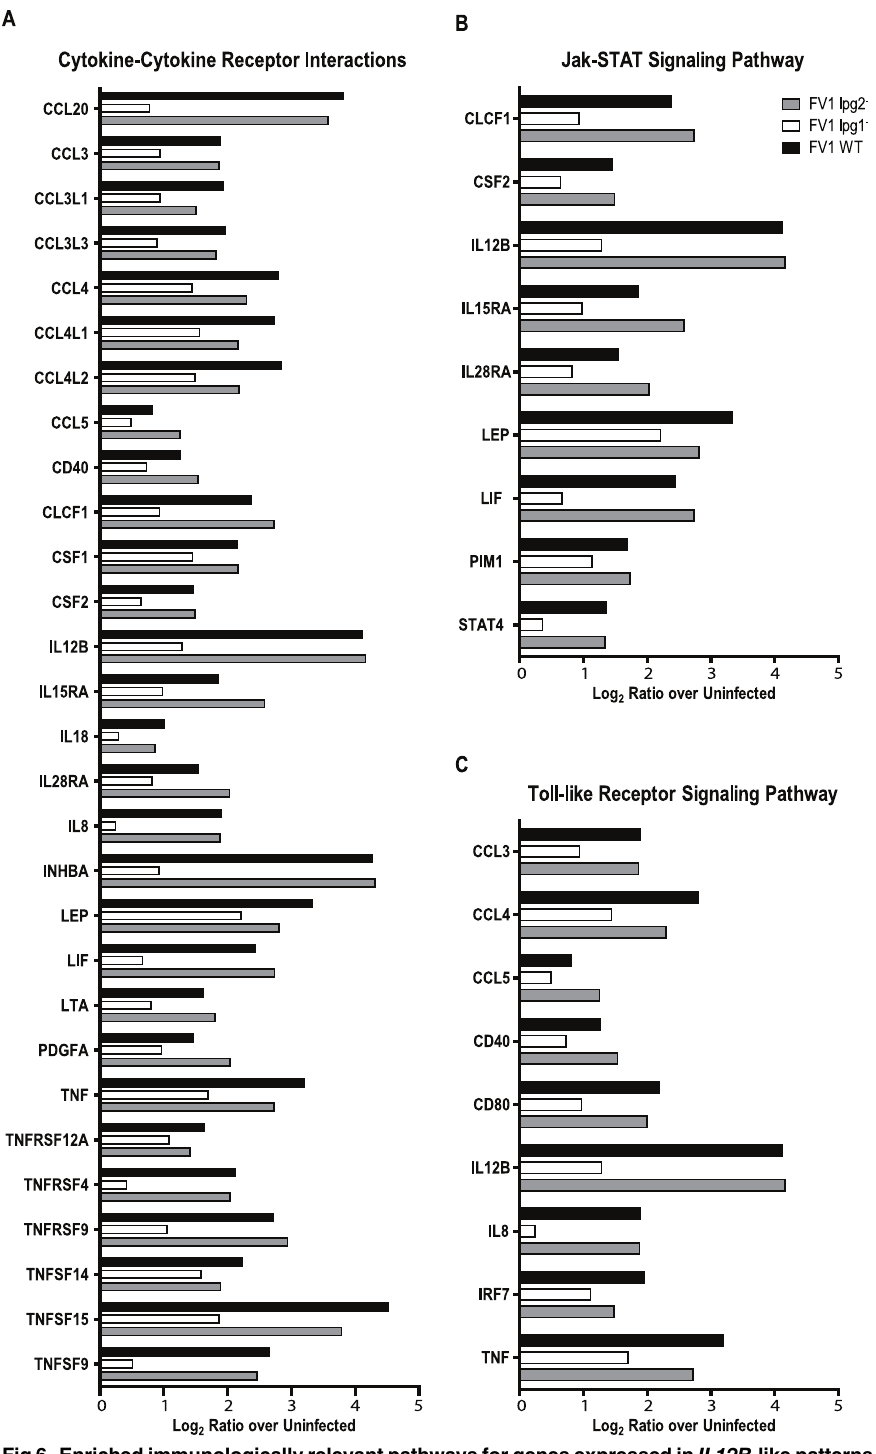
Fig 6. Enriched immunologically relevant pathways for genes expressed in IL12B -like patterns. Gene transcripts lists from L . major FV1 WT, FV1 lpg1 − , and FV1 lpg2 − mutant in vitro infected monocyte-derived hDCs microarray analysis, with log 2 ratio over uninfected value patterns between samples that clustered with the IL12B , were analyzed to identify significantly enriched (Benjamini and Hochberg adjusted p < 0.01) KEGG pathways. Three immunologically relevant pathways, which also contained IL12B , were enriched among that gene list: cytokine-cytokine receptor interactions (A), Jak-STAT signaling pathway (B), and toll-like